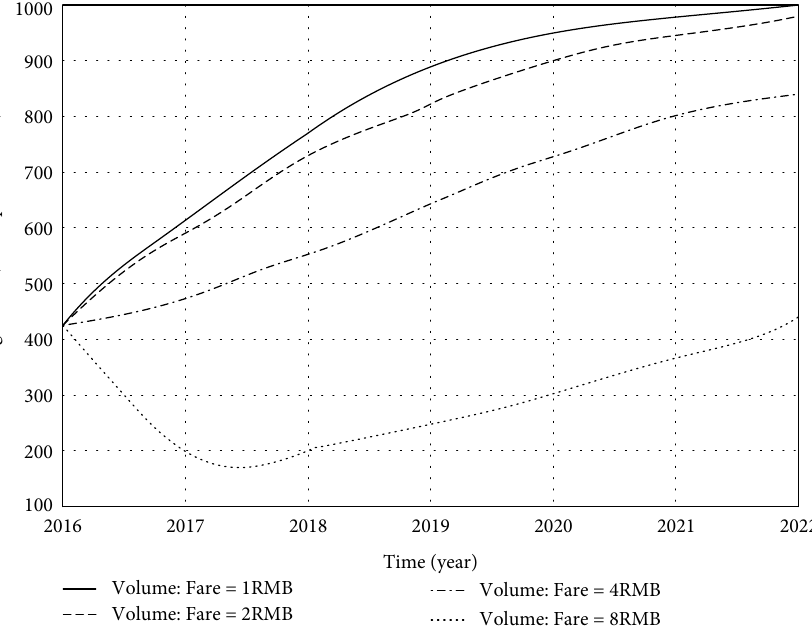
Figure 8: The impact of service level on passenger flow.